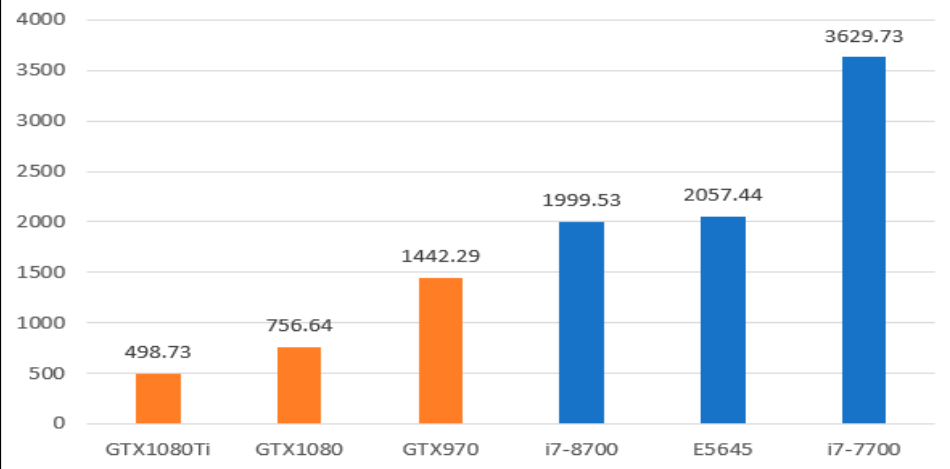
Figure 13. Costs of PoW executed by different resources.